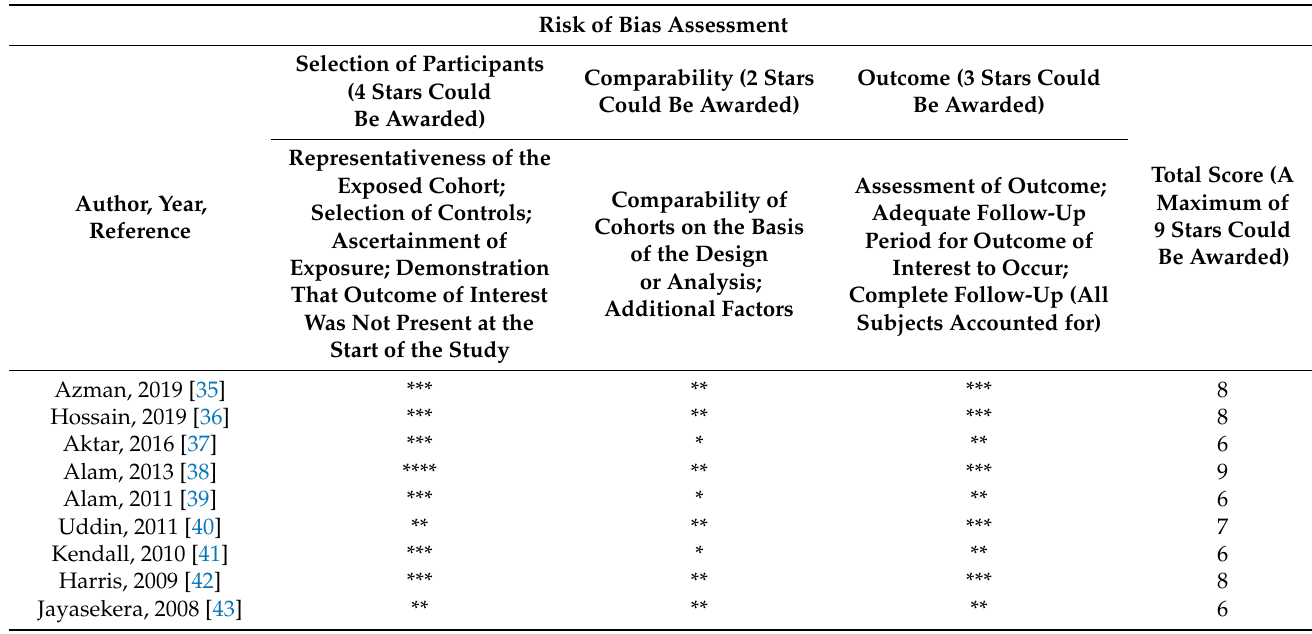
Table A2. Quality assessment of included studies ( n = 9)